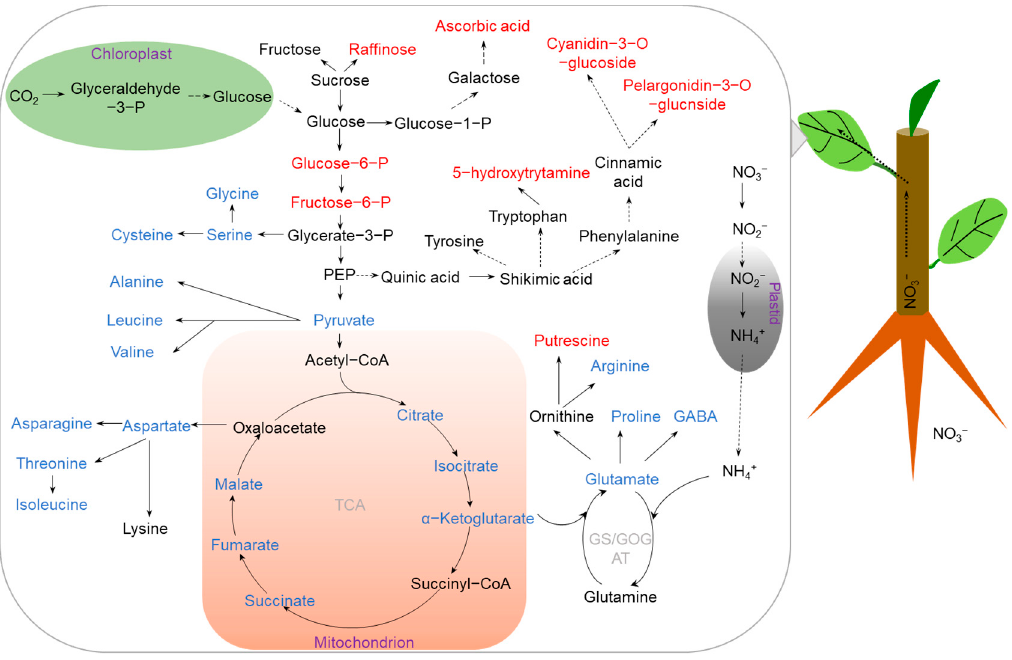
Figure 1. Metabolic pathways changes in crop leaves under N deficiency. N deficiency inhibits the N assimilation pathway and TCA cycle, resulting in large decreases in amino acids, while it accumulates tolerance-related metabolites for reactive oxygen species (ROS) scavenging. The accumulated and reduced metabolites are marked in red and blue, respectively. Abbreviations: P (phosphate), PEP (phosphoenolpyruvic acid), GABA ( γ -aminobutyric acid), TCA (tricarboxylic acid), GS/GOGAT (glutamine synthetase/glutamate synthetase).